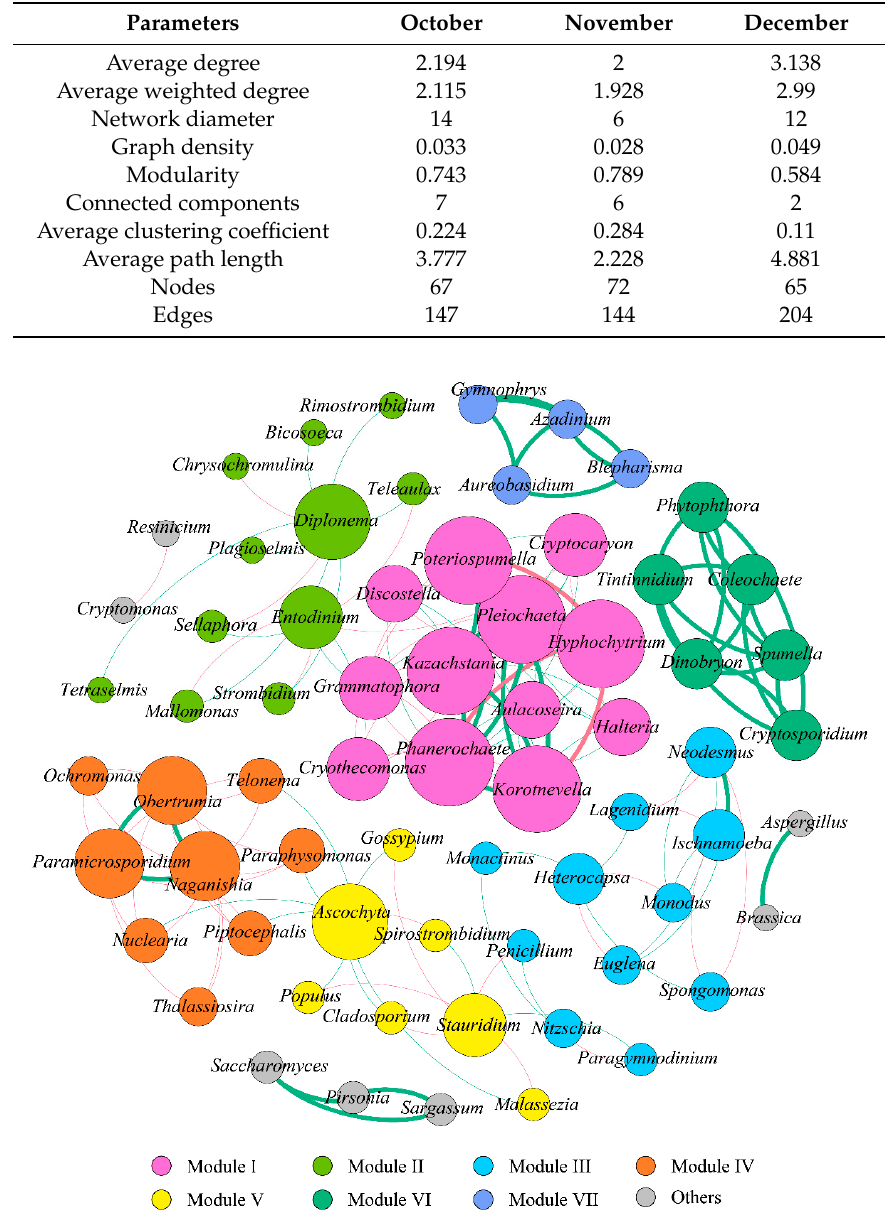
Table 4. Network parameters of eukaryote community compositions based on the 18S DNA sequence at the genus level (R = 0.8).